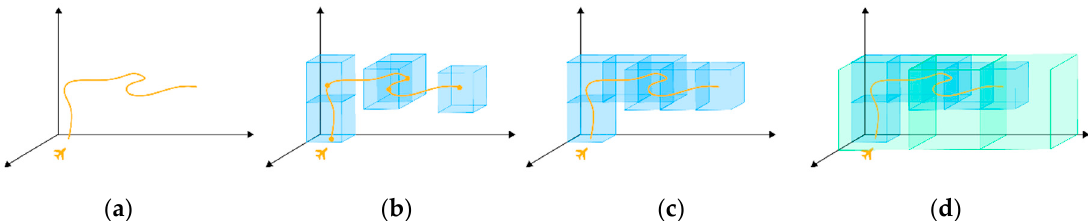
Figure 4. Path discretization. ( a ) flight path; ( b ) GeoSOT grid cells at key points along the flight path; ( c ) The path is discretized into higher level GeoSOT grids (smaller grid); ( d ) The path is discretized into lower level GeoSOT grids (bigger grid )